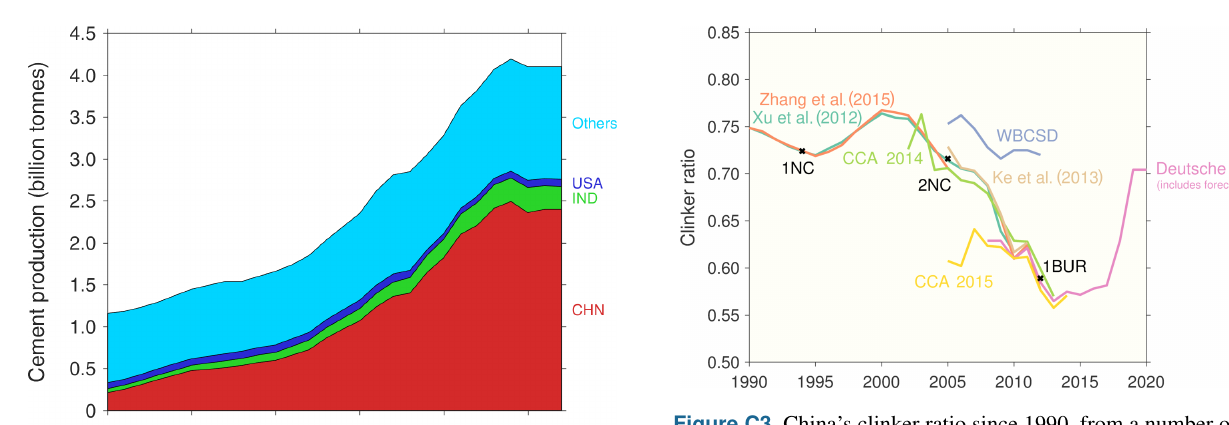
Figure C3. China’s clinker ratio since 1990, from a number of dif- ferent sources. The three official estimates are marked in black: 1NC is the first National Communication, 2NC the second National Communication, and 1BUR is the first Biennial Update